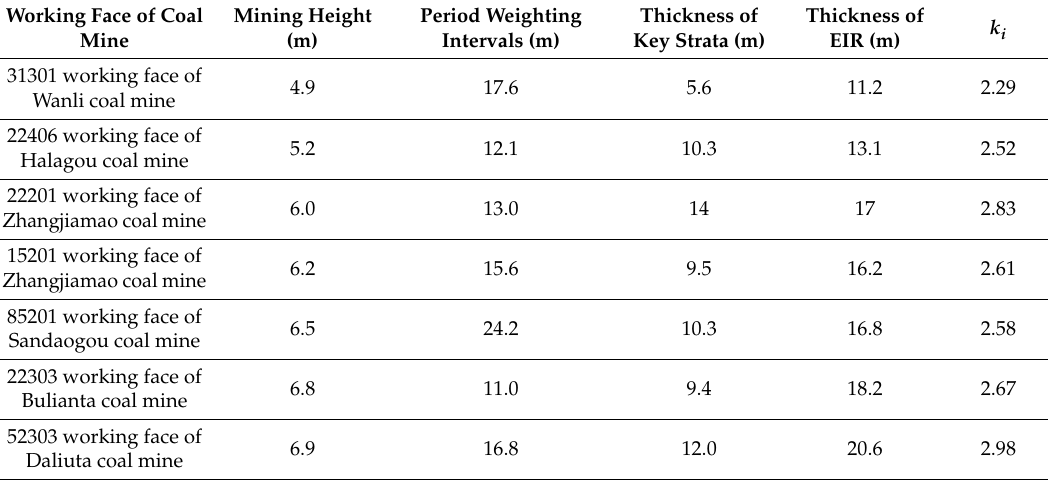
Table 1. Equivalent immediate roof thickness of large mining height